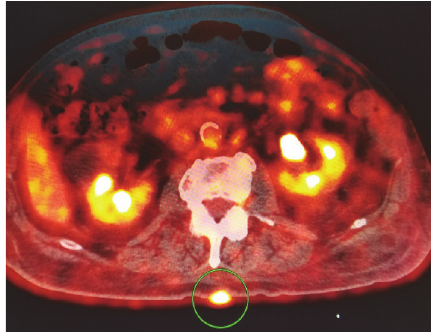
Figure 4: PET scan identifies intensely hypermetabolic cutaneous lesion of the back. This patient has a history of multiple hyperme- tabolic cutaneous lesions with excisions.